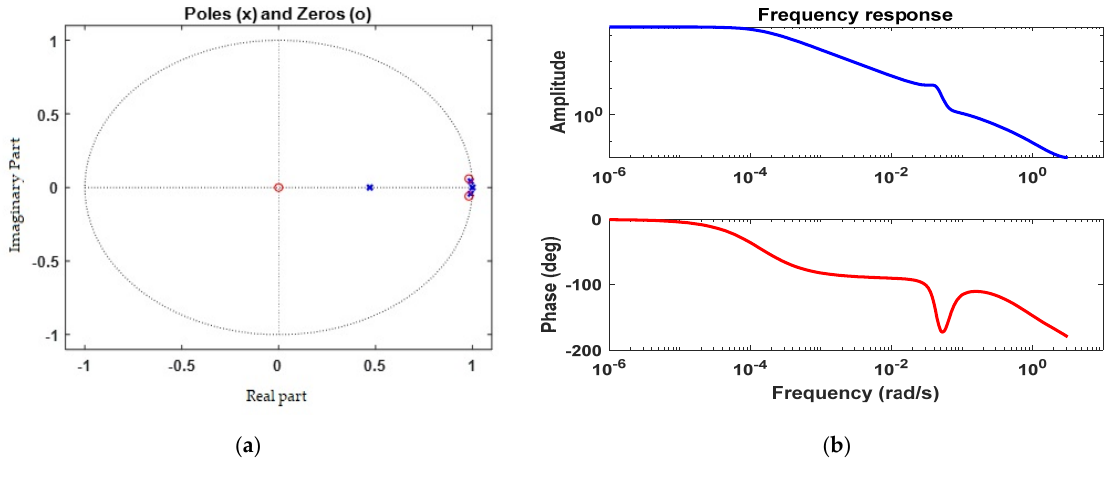
Figure 5. ( a ) Poles and zeroes; ( b ) frequency response.